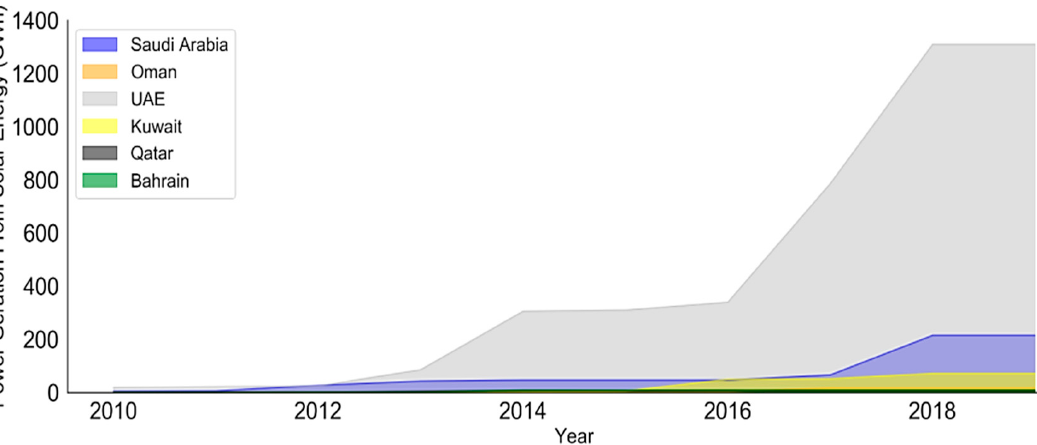
Figure 9. Energy generation from solar energy in GCC region, 2010–2019.